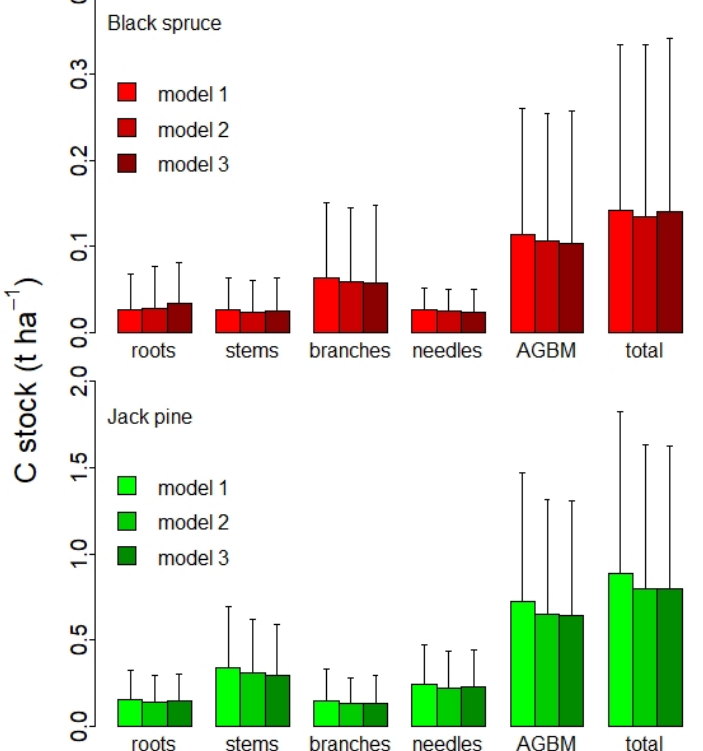
Figure 7. Estimates of carbon stocks (t C·ha − 1 ) for each tree compartment (stems, needles, branches, roots), aboveground biomass (AGBM), and total tree biomass in OWs planted with black spruce (BS) and jack pine (JP) at a density of 2000 Table 1. Each value is the mean ± SD of seven sites (Figure 1).